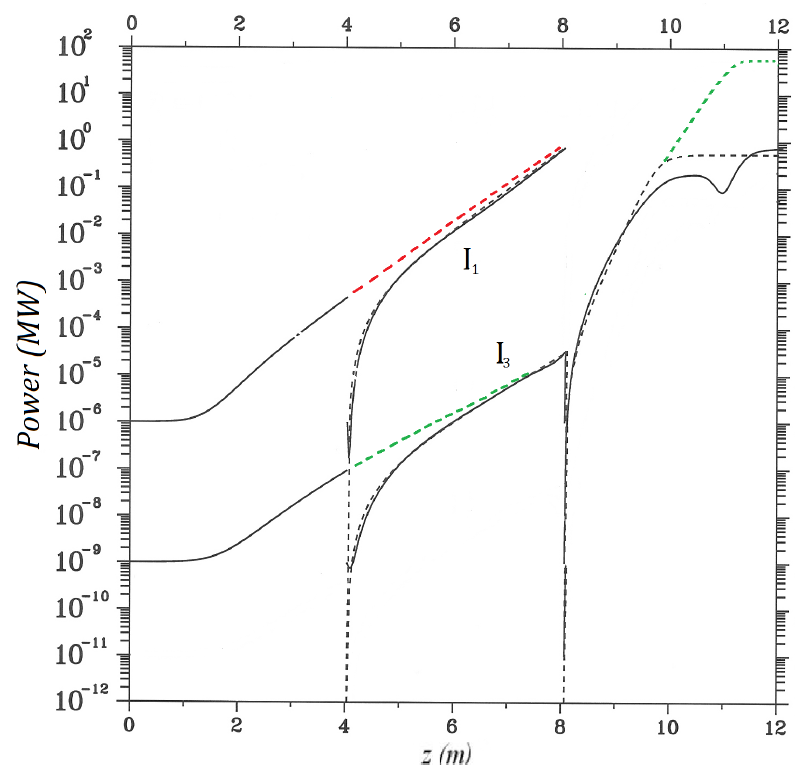
Figure 7. First and third harmonic evolution, in a segmented undulator. At each undulator segment (4 and 8 m) the field growth is dominated by the bunching acquired during the interaction inside the undulator segment. The red and green lines represent the growth with the inclusion of the intensity (considered to be a kind of seeding). The final section, where nonlinear harmonic generation occurs, is dominated by the bunching, when the second beam is superimposed the power intensity grows according to the usual